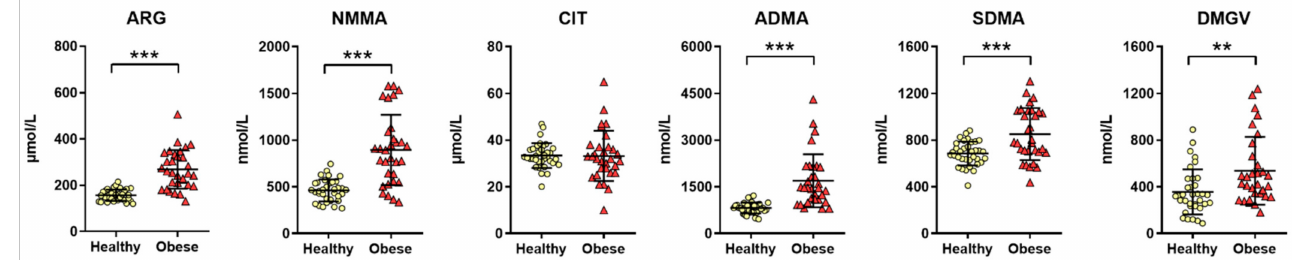
Figure 1. Comparison of the methylarginine metabolite plasma concentrations between the healthy and obese subjects at baseline. **: p < 0.01; ***: p < 0.001 (Mann–Whitney test, Benjamini–Hochberg correction for multiple testing). ARG, arginine; NMMA, N-monomethylarginine; CIT, citrulline; ADMA, asymmetric dimethylarginine; SDMA, symmetric dimethylarginine; DMGV, dimethylguanidino